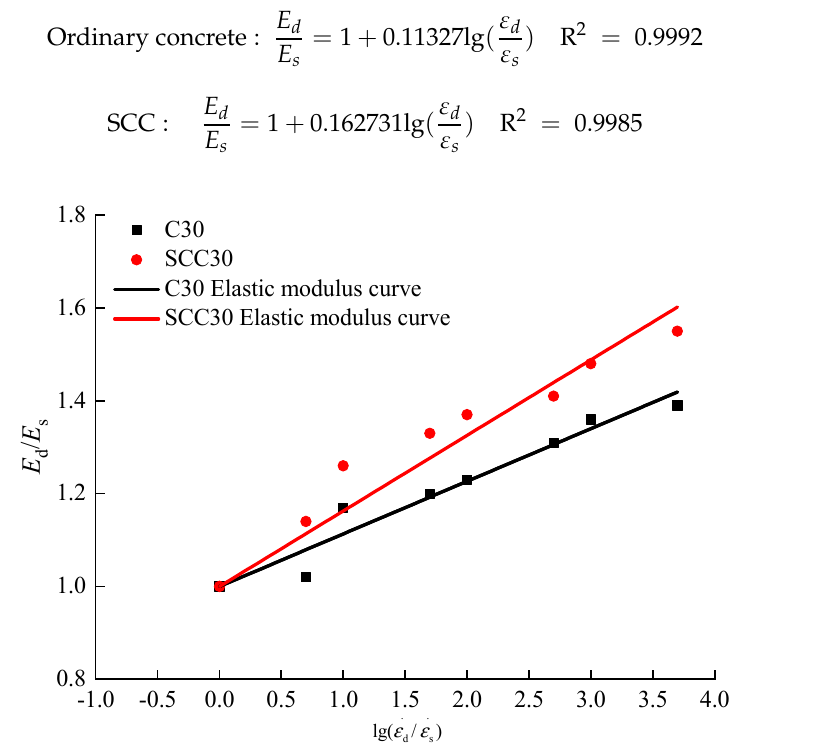
Figure 11. Relationship between strain rate and dynamic increase coefficient of elastic modulus.